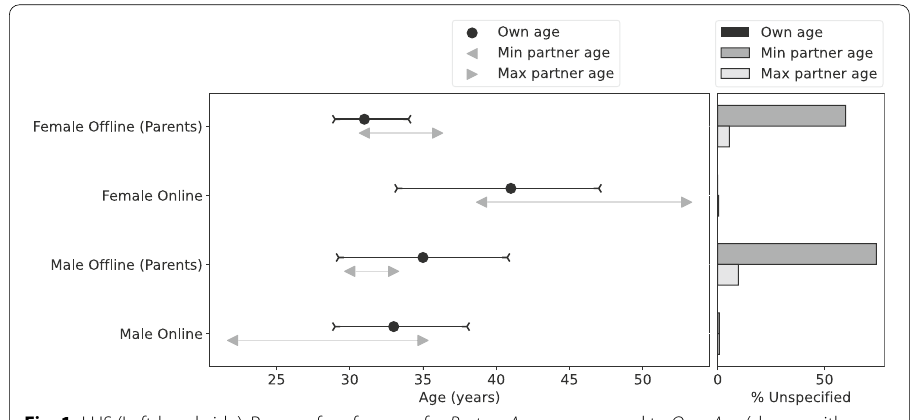
Fig. 1 LHS (Left-hand-side): Range of preferences for Partner Age as compared to Own Age (shown with mean and IQR (interquartile range)). The subgroups displayed are grouped by gender and degree of parental involvement (online vs. offline sample). RHS (Right-hand-side): The proportion of profiles that did not specify Own Age or Min/Max Partner